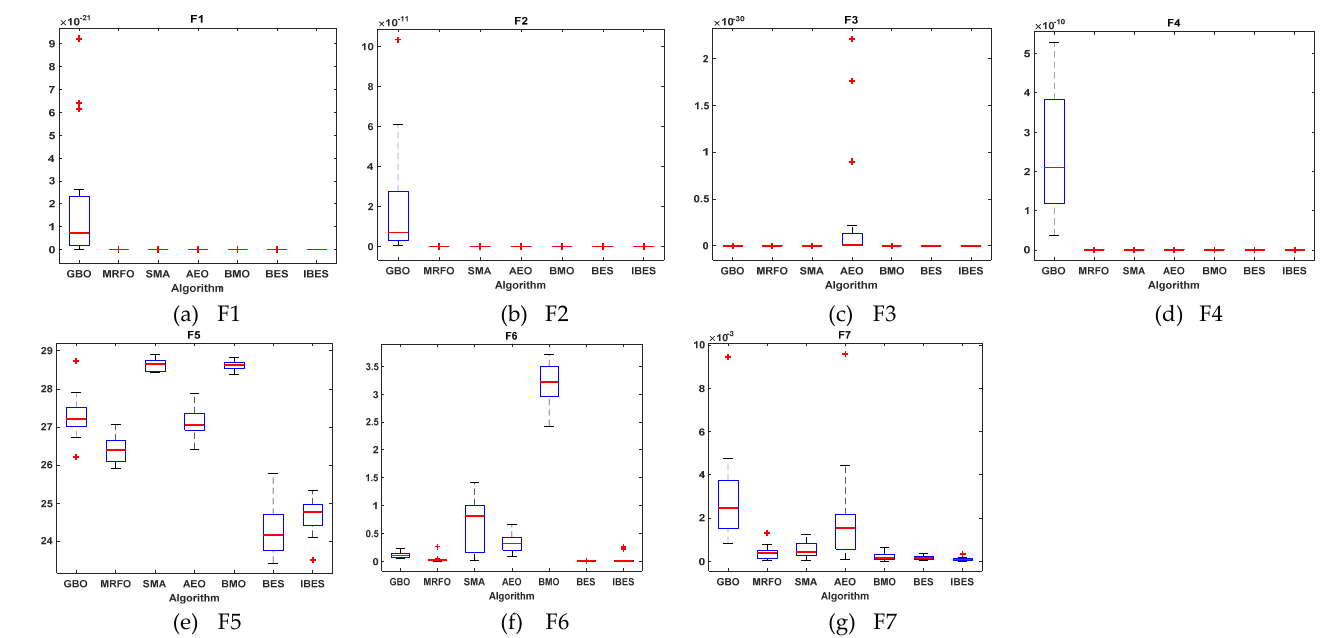
Figure 10. Boxplots for all algorithms for unimodal benchmark functions ( a ) F1, ( b ) F2, ( c ) F3, ( d ) F4, ( e ) F5, ( f ) F6, and ( g ) F7.